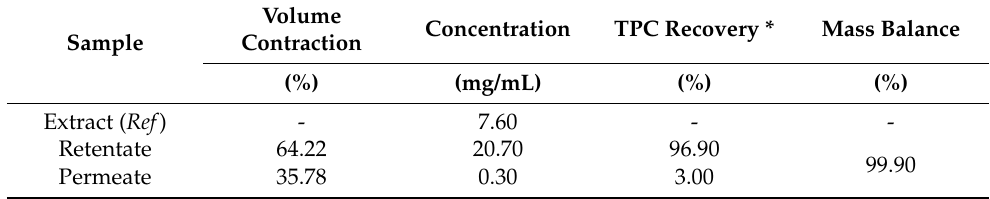
Table 9. NF protocol. Volume contraction, TPC variations, and mass balance of the process.